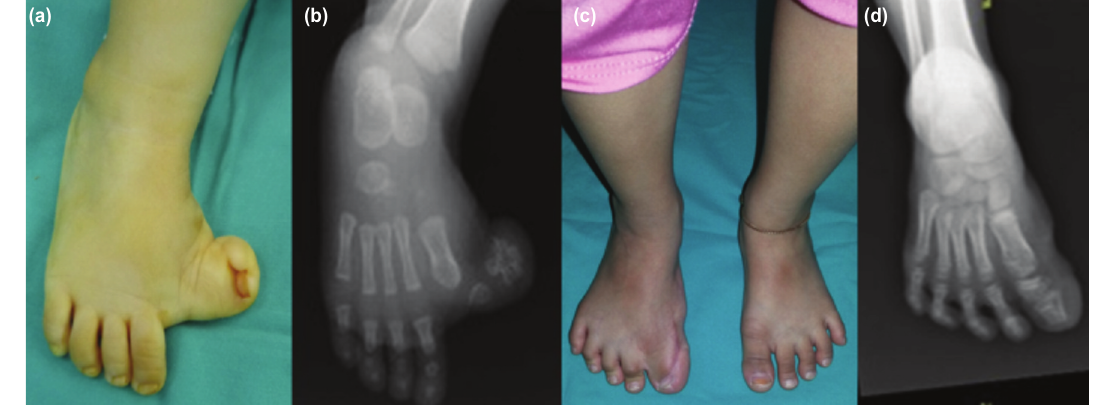
(a) Pre-operative photograph of case No. 1 shows a severe right hallux varus with wide first web space and polysyndactyly of Fig. 1: the right big toe. (b) Radiograph shows a bifid distal phalanx of the right hallux. (c) Post-operative photograph after Farmer’s procedure with creation of syndactyly of the first web space and realignment of the right big toe. (d) Post-operative radiograph shows a well reduced first metatarsophalangeal joint and a corrected right hallux varus.